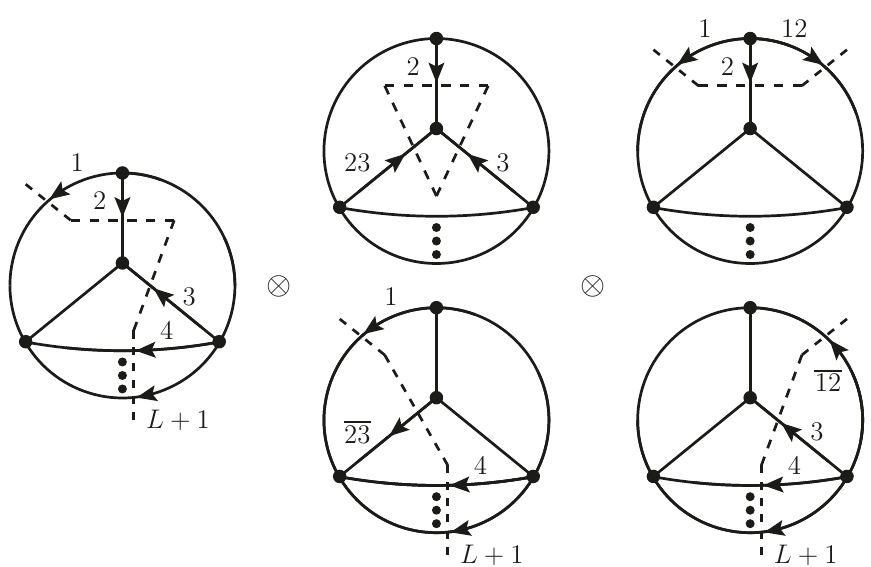
Figure 5 . Entangled causal thresholds of the N 2 MLT topology. External momenta not shown. and N ( { q (+) } ) a degree-four polynomial in q (+) i, 0